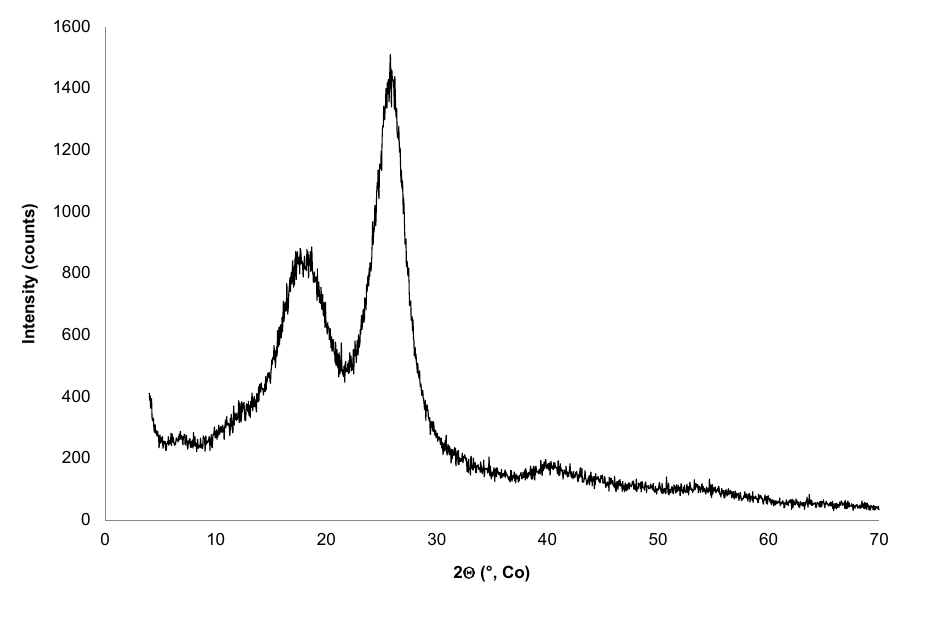
Figure 3. X-ray diffraction pattern of the